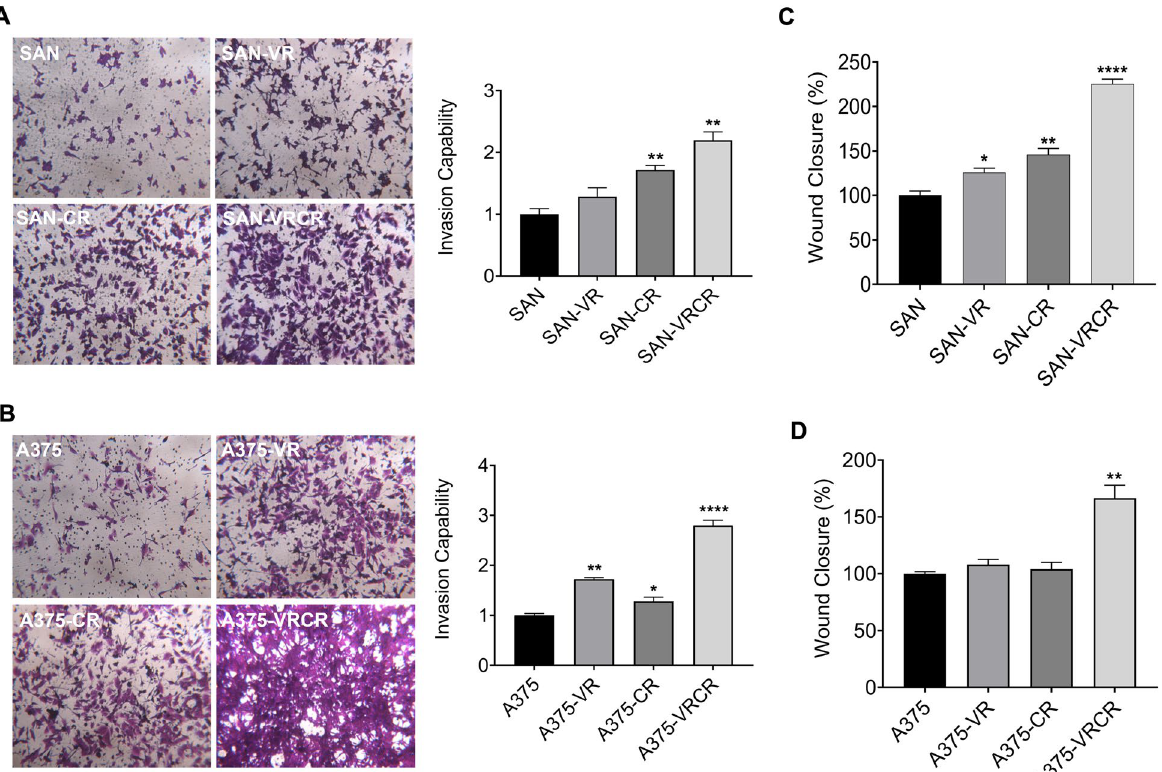
Fig. 2 Characterization of vemurafenib and/or cobimetinib-resistant melanoma cell lines. A Cell invasion ability of SAN, SAN-VR, SAN-CR and SAN-VRCR cell lines evaluated by Transwell invasion assay after 48 h in basal condition. B Cell invasion ability of A375, A375-VR, A375-CR and A375-VRCR cell lines evaluated by Transwell invasion after 48 h in basal condition. C , D Wound healing assays performed to detect migration ability of C SAN, SAN-VR, SAN-CR and SAN-VRCR cell lines and D A375, A375-VR, A375-CR and A375-VRCR cell lines after 48 h of culture. * <0,05. **: P < 0.001; ****: P <